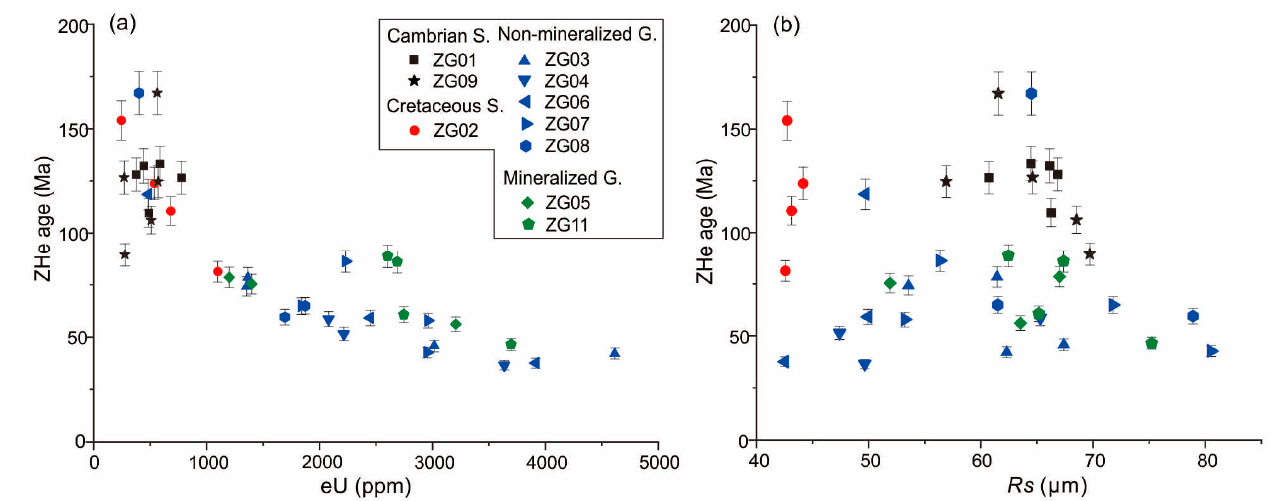
Figure 3. ( a ) Plots of ZHe age versus effective uranium (eU) content and ( b ) equivalent spherical radius ( Rs ) for the Lujing uranium ore field samples. S. = sandstone, G. = granite.